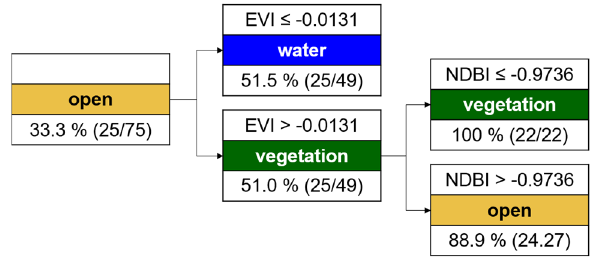
Figure A4. CART for February 2017.